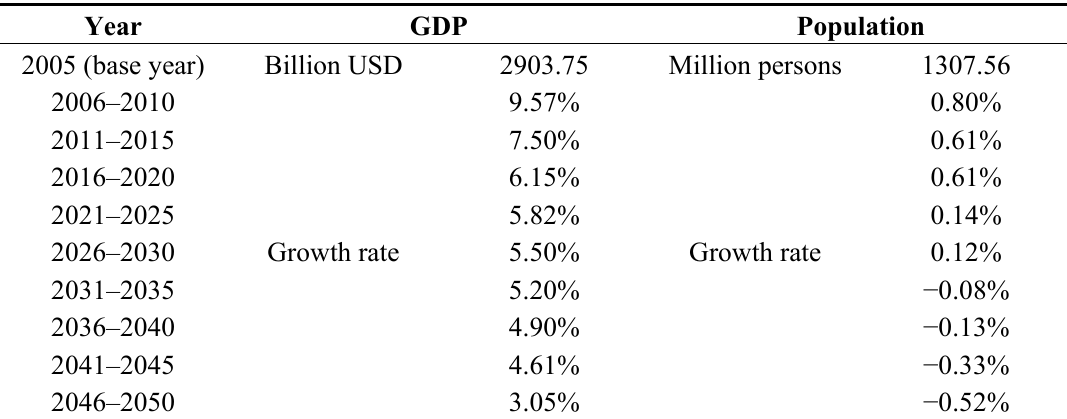
Table 1. GDP and population growth.